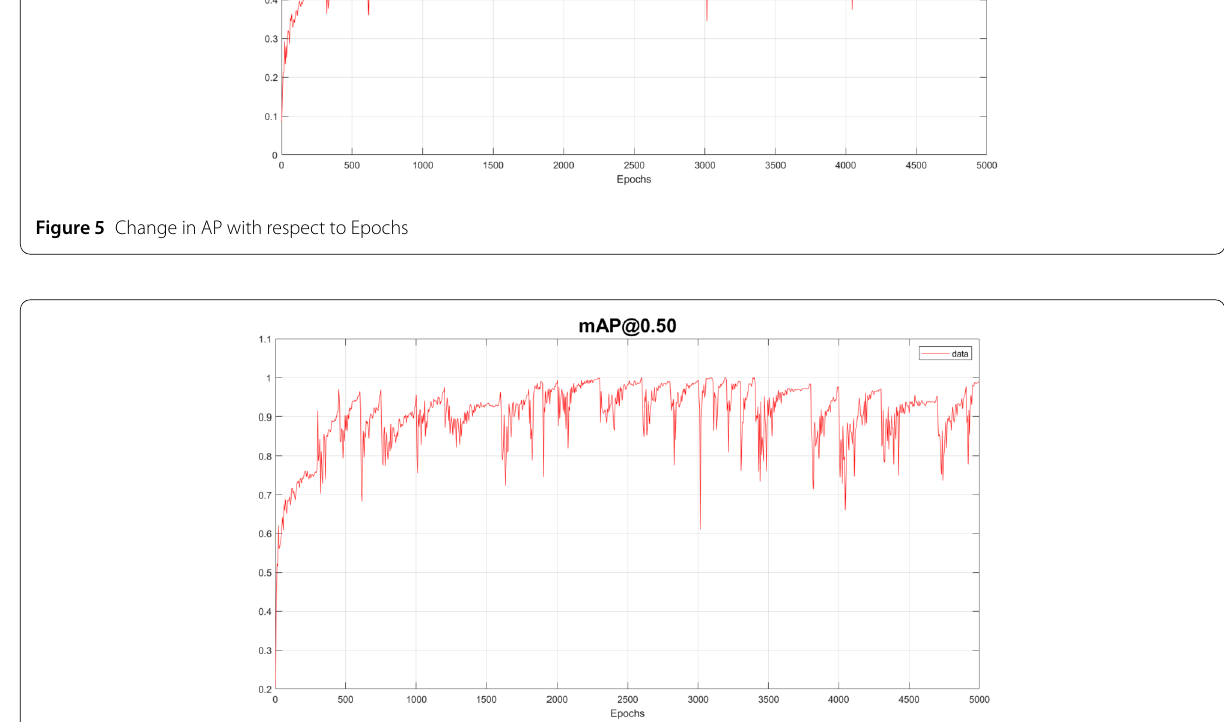
Figure 6 Change in mAP@0.50 with respect to Epochs